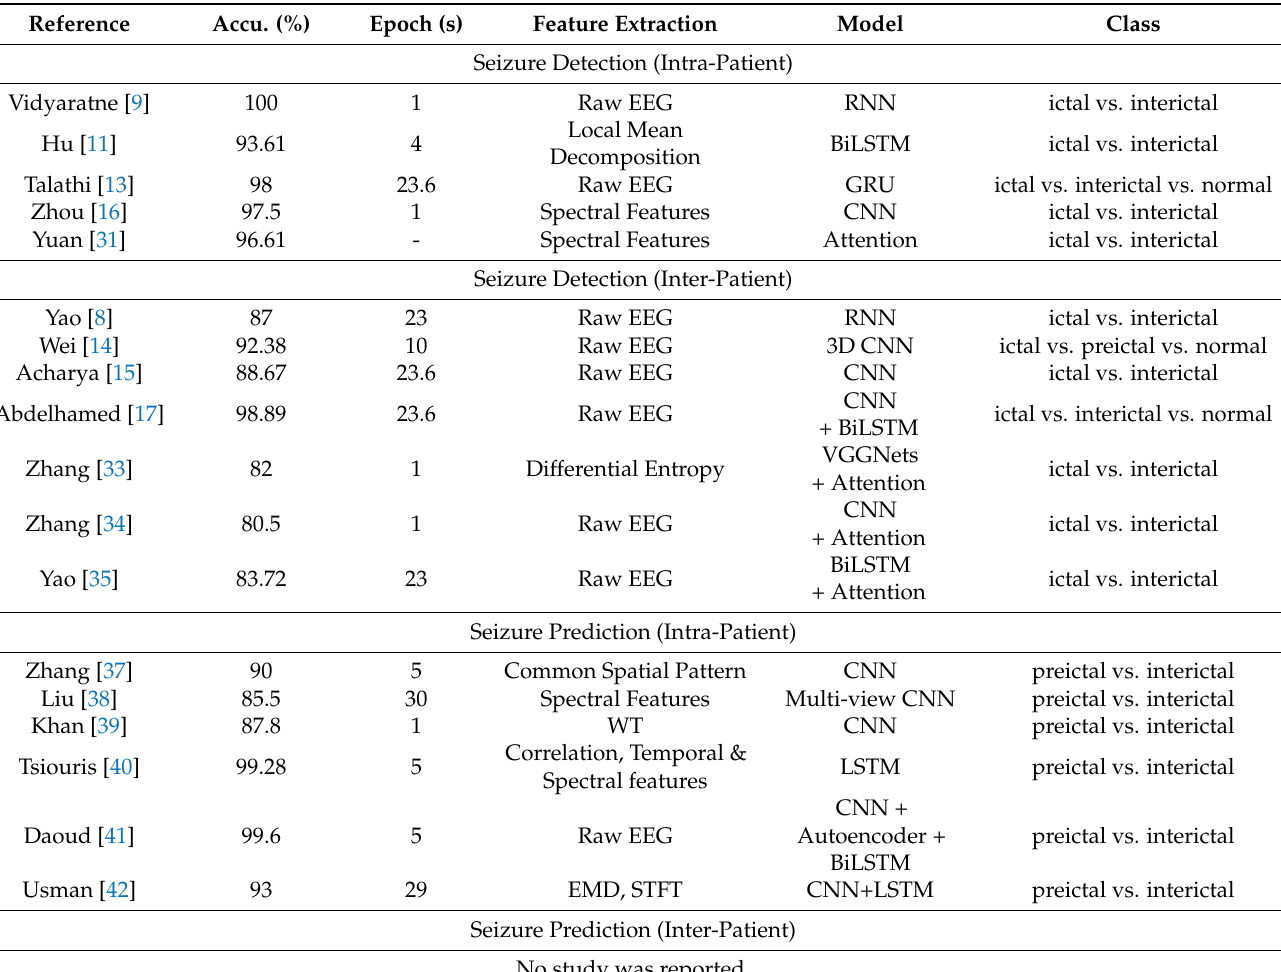
Table 1. Summary of related